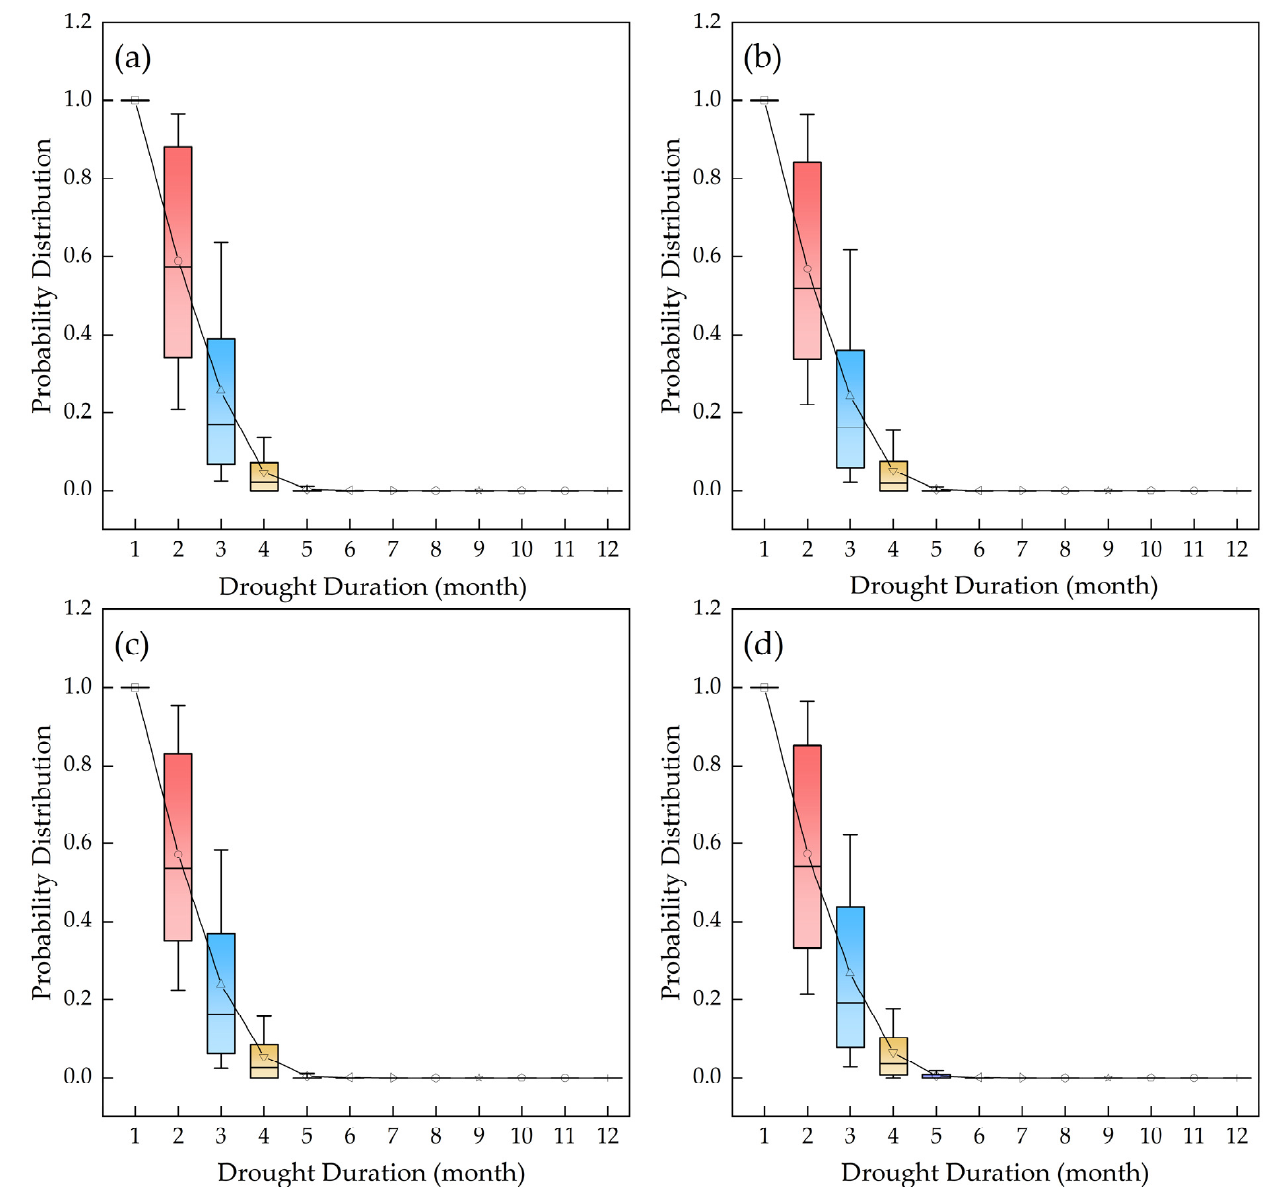
Figure 12. Relationship between drought duration and migration probability distribution on the TP under the ( a ) RCP2.6, ( b ) RCP4.5, ( c ) RCP6.0, and ( d ) RCP8.5 climate scenarios.